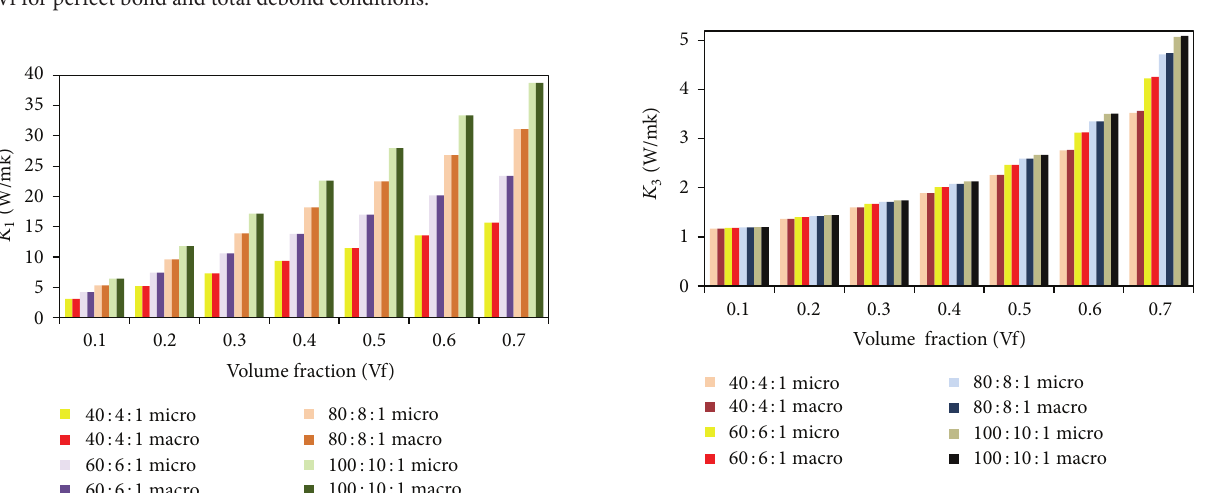
Figure 9: Variation in transverse thermal conductivity with respect to Vf for perfect bond and total debond conditions.